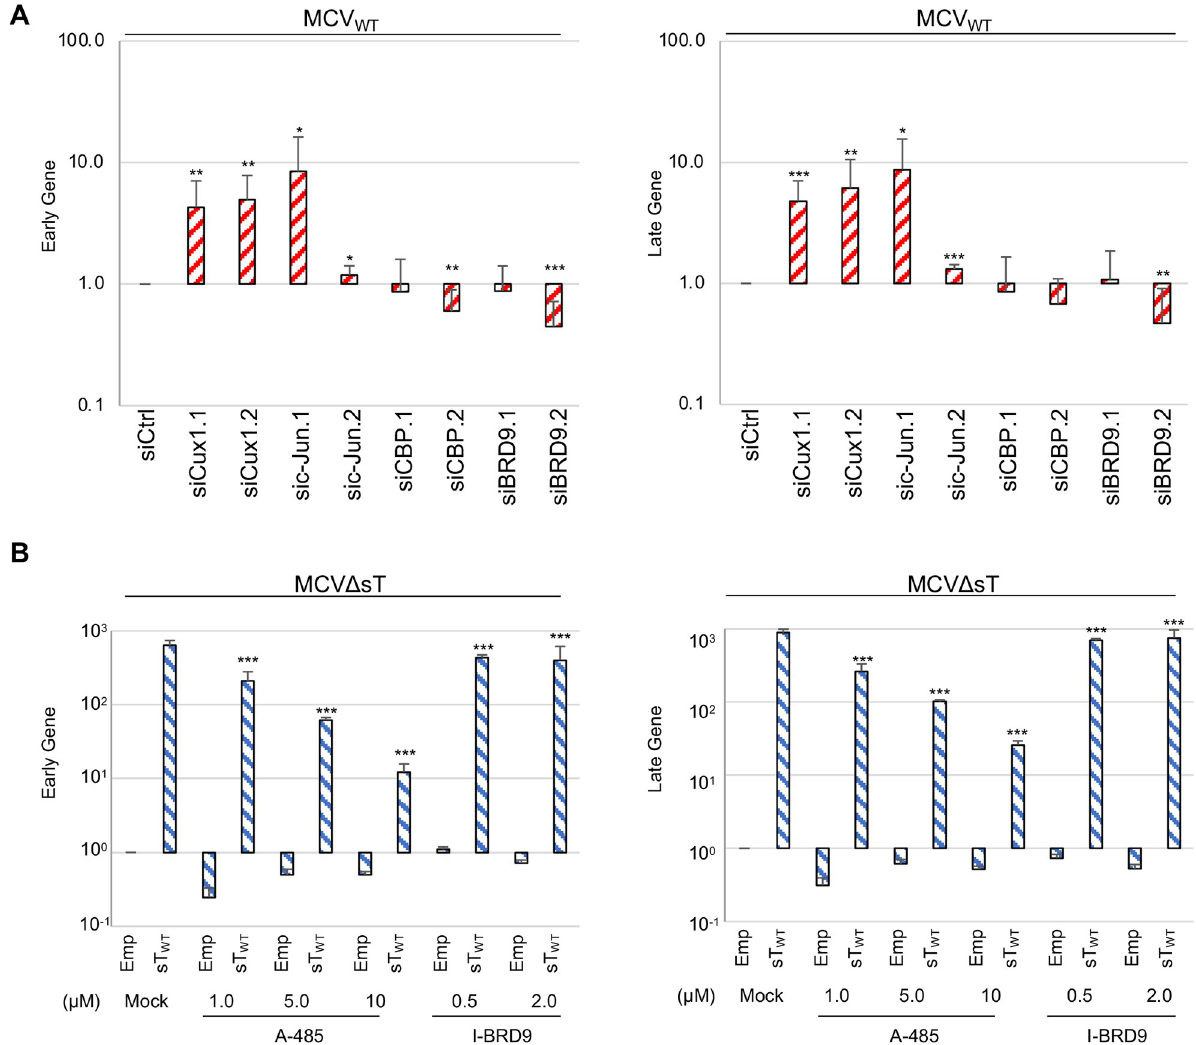
Fig 8. Role of sT-interacting proteins in MCV transcription and viral replication. (A) Effect o f siRNA knockdown of sT interactors on viral gene expression in MCV WT . siRNA treatment of MCV WT samples. In cells treated with siCux1.1, siCux1.2, sic-Jun.1, and sic-Jun.2, early and late gene expression increases relative to the siCtrl. In cells treated with siCBP.2 and siBRD9.2, early and late gene expression decreases. Total RNA was subjected to qRT-PCR analysis by the 2 - ΔΔ Ct method using VP2 (set 1) and PanT primer pairs with 18S ribosomal RNA for normalization. Error bars indicate SD. Unpaired T-test was used for statistical analysis to determine the significance relative to siCtrl. � , P < 0.05; �� , P < 0.01; ��� , P < 0.001. (B) A-485 and I-BRD9 treatment of MCV Δ sT transfected with empty or sT. A-485 treatment significantly decreases early and late gene expression at 1.0, 5.0, and 10.0 μ M in MCV Δ sT transfected with sT. I-BRD9 treatment at 0.5 and 2.0 μ M also significantly decreases early and late gene expression. Total extracted RNA was subjected to qRT-PCR analysis as described in Fig 8A. Relative mRNA expression to the sT WT -transfected sample is shown. Error bars indicate SD. Unpaired T-test was used for statistical analysis. � , P < 0.05; �� , P < 0.01; ��� , P < 0.001.